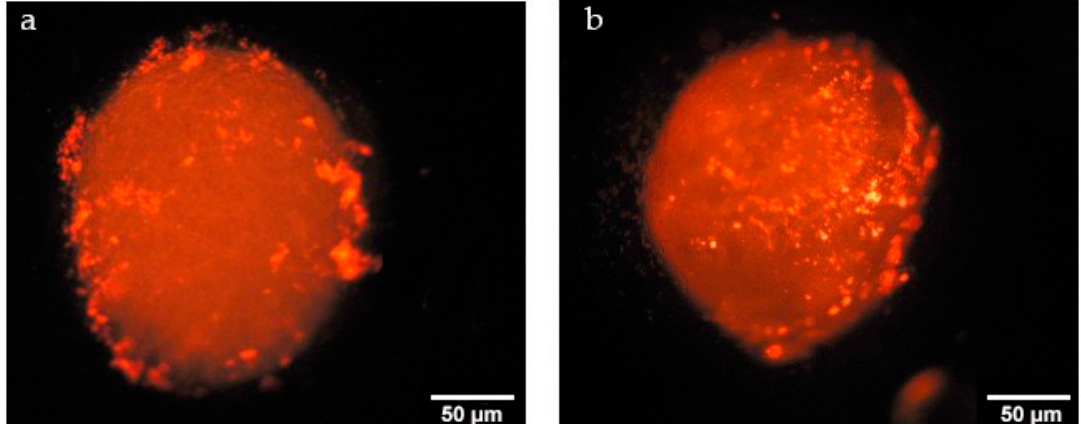
Figure 16. Nile red loaded 6OCapro β CD ( a ) and PC β CDC6 nanoparticles ( b ) on MCF-7: HDF spheroids.